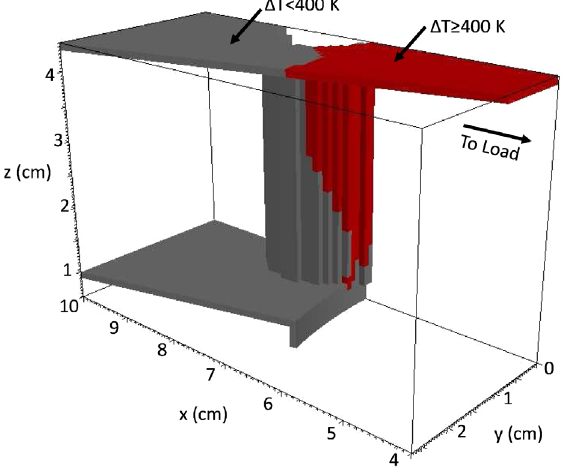
FIG. 2. Surface temperature increase along anode components due to Ohmic heating from a dI=dt ¼ 0 . 2 MA = ns pulse after 100 ns. The gray shaded regions do not reach Δ T ¼ 400 K for this